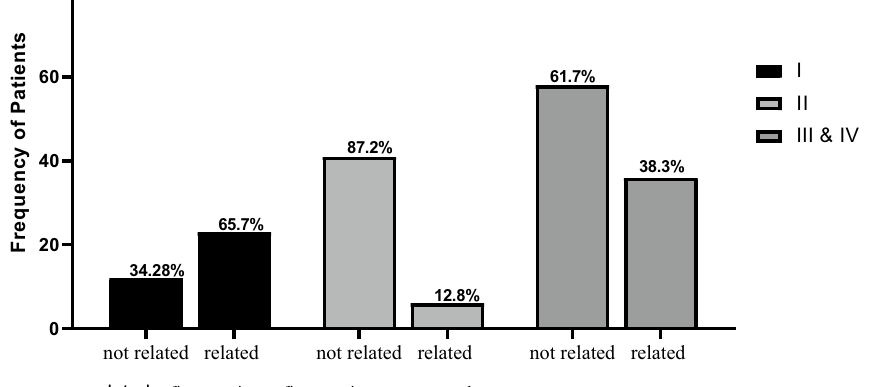
Figure 4. The distribution of clinical phenotypes (SMA subtypes) between patient’s groups with/without parental relationship. Chi-square (2 × 3 contingency table) was performed to compare the distribution of clinical phenotypes between patient’s groups (not related and related